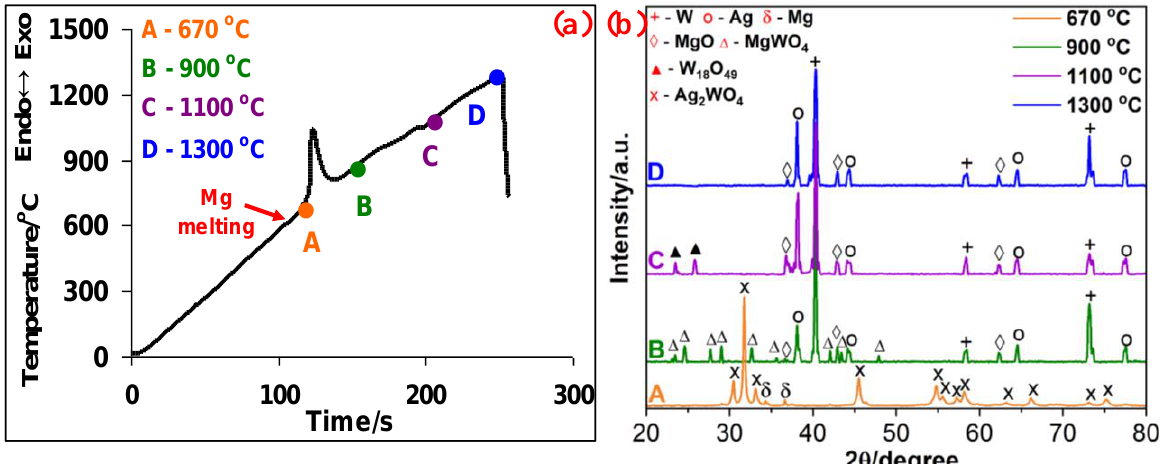
Figure 2. Heating curve of the Ag 2 WO 4 + 4Mg mixture, β = 300 °C min −1 ( a ) and XRD analysis results of the quenched samples ( b ).